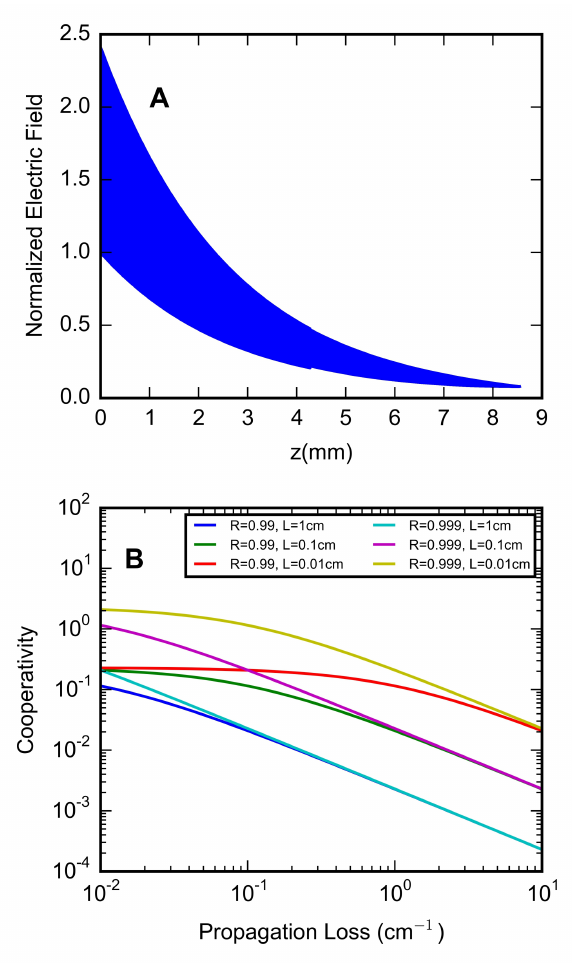
Fig. 13. (A) Electric field distribution of a 20,000 period Bragg grat- ing starting at z = 0, with incoming field amplitude of 1. (B) Coop- erativity vs. propagation loss for a Fabry-Perot cavity formed using a hollow core ARROW waveguide with mode area of 18 µm 2 , for vari- ous lengths and mirror reflectivities.